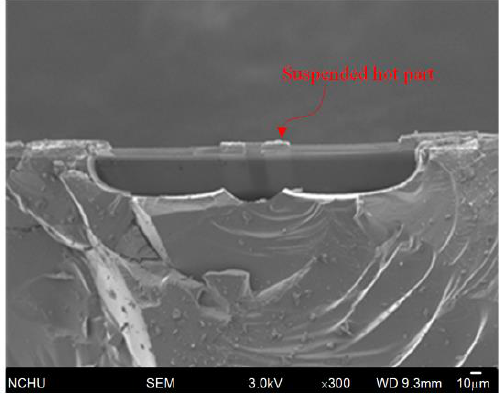
Figure 10. Cross-sectional view of the microgenerator.